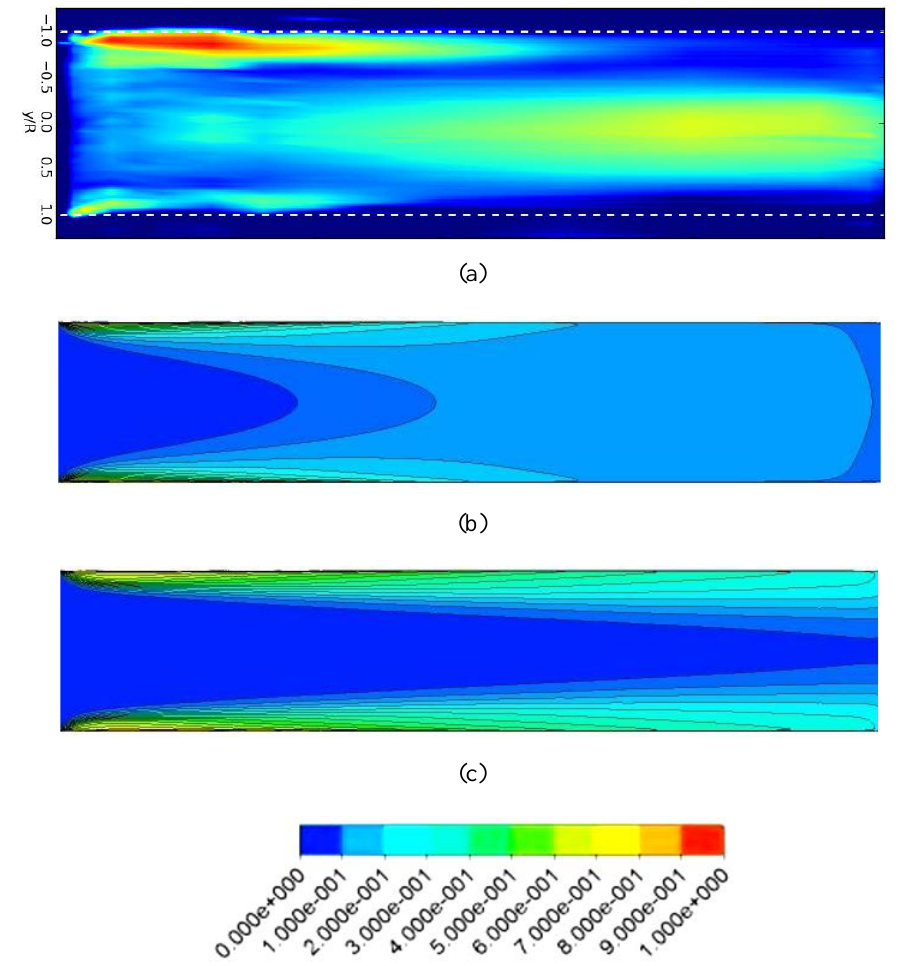
Figure 7. Qualitative comparison of vapor volume fraction between the experimental and CFD predicted results. ( a ) X-ray radiography measurement at CN = 11.2 [15], ( b ) standard k-epsilon, ( c ) realizable k-epsilon.